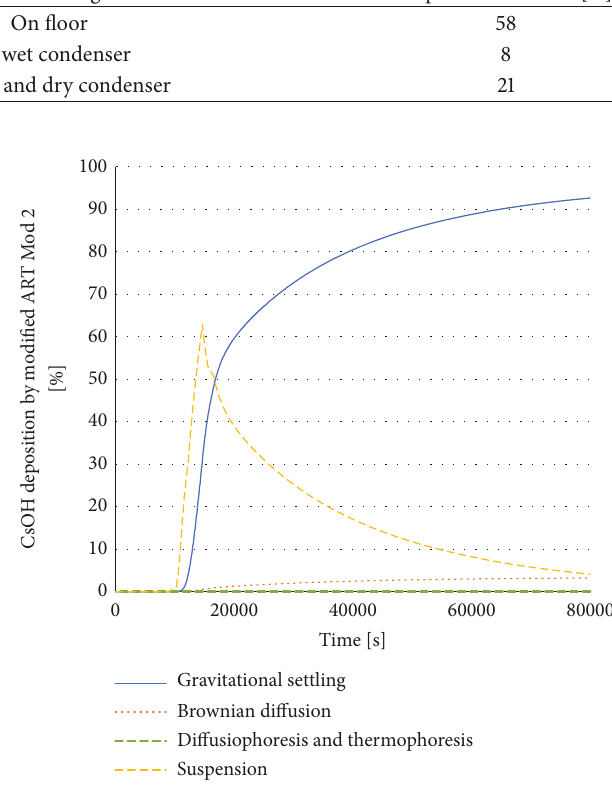
Figure 12: CsOH deposition in containment vessel volume calcu- lated by ART Mod 2.